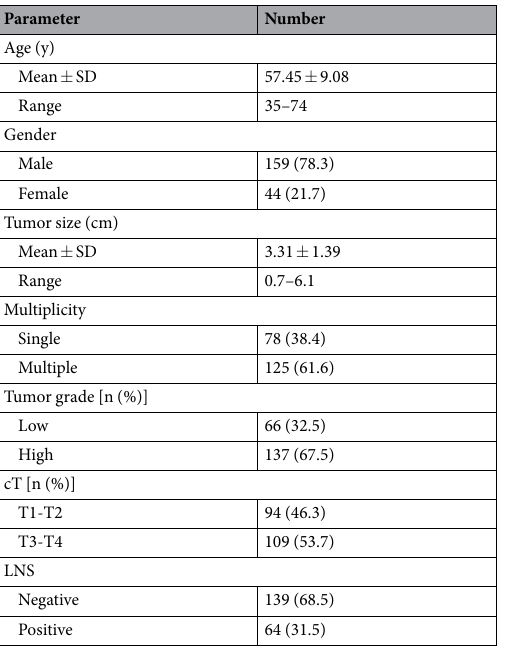
Table 1. Clinical and pathological parameters of 203 patients with BUC.